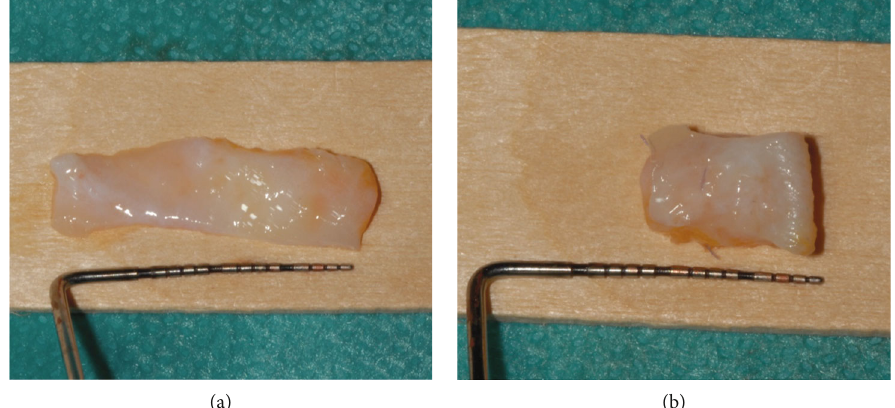
Figure 4: (a) Deepithelialized free gingival graft. (b) Connective tissue graft folded in two layers and then sutured, to gain soft-tissue thickness in the vertical direction.